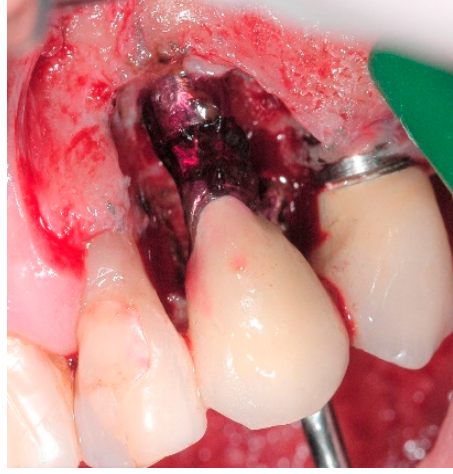
Figure 4. HYBENX ® treatment .